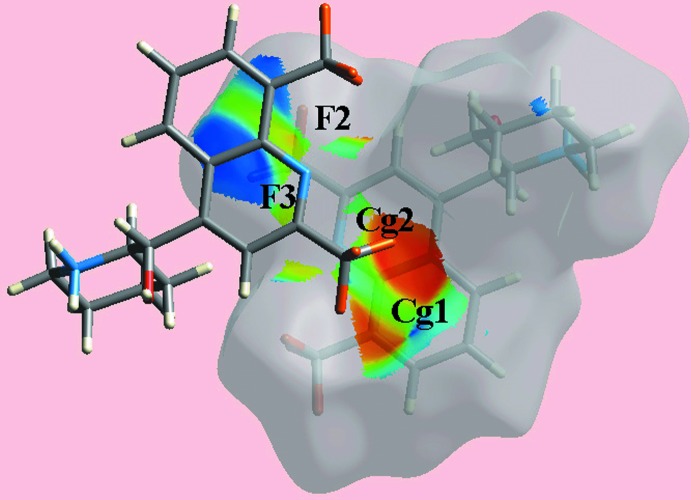
A view of Hirshfeld surface mapped over the shape-index property highlighting the inter­molecular C—F⋯π/π⋯F—C contacts by blue bumps and bright-orange concave regions.